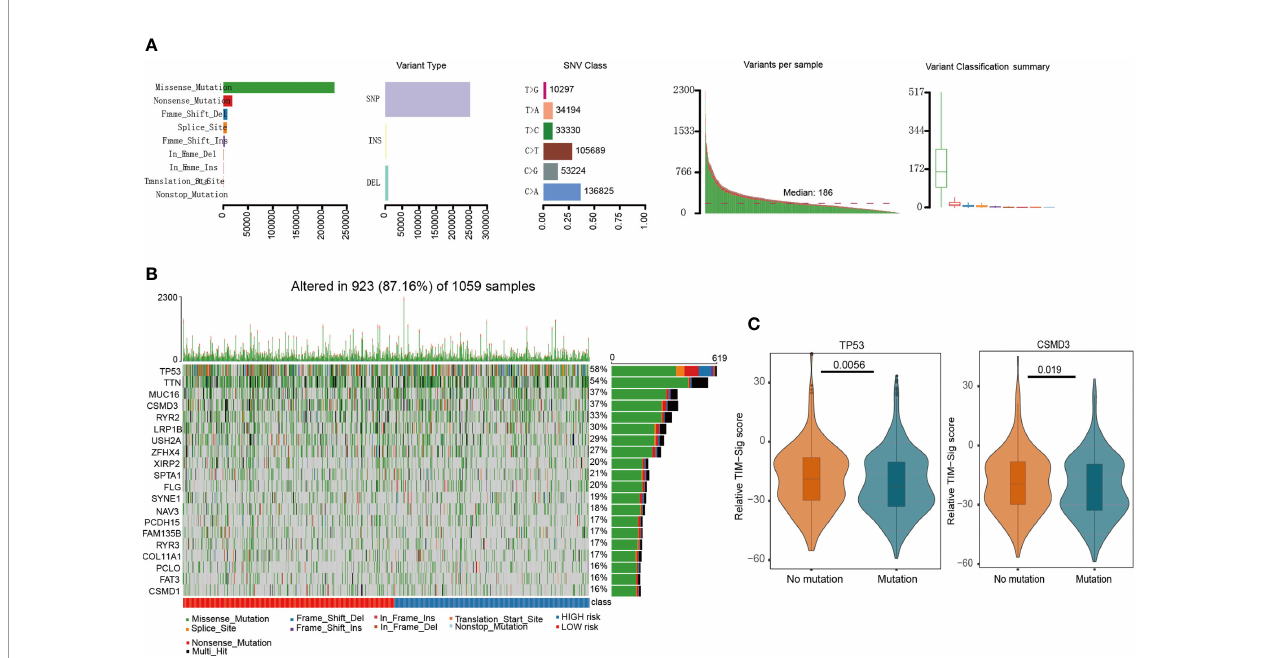
FIGURE 3 | Mutations in NSCLC samples. (A) We utilized the maftools package to visualize the mutational features in NSCLC. In summary, we classi fi ed these mutation data into different categories, where missense mutation occupied the most part, single nucleotide polymorphism (SNP) mutated the most frequently, and C>A was the top type of single nucleotide variants (SNV) in NSCLC. (B) We exhibited the top 20 mutated genes, including well-known TP53 and MUC16. (C) The difference of TIM-Sig score in mutation and wild groups of TP53 and CSMD3. The p-values were calculated using the Wilcoxon